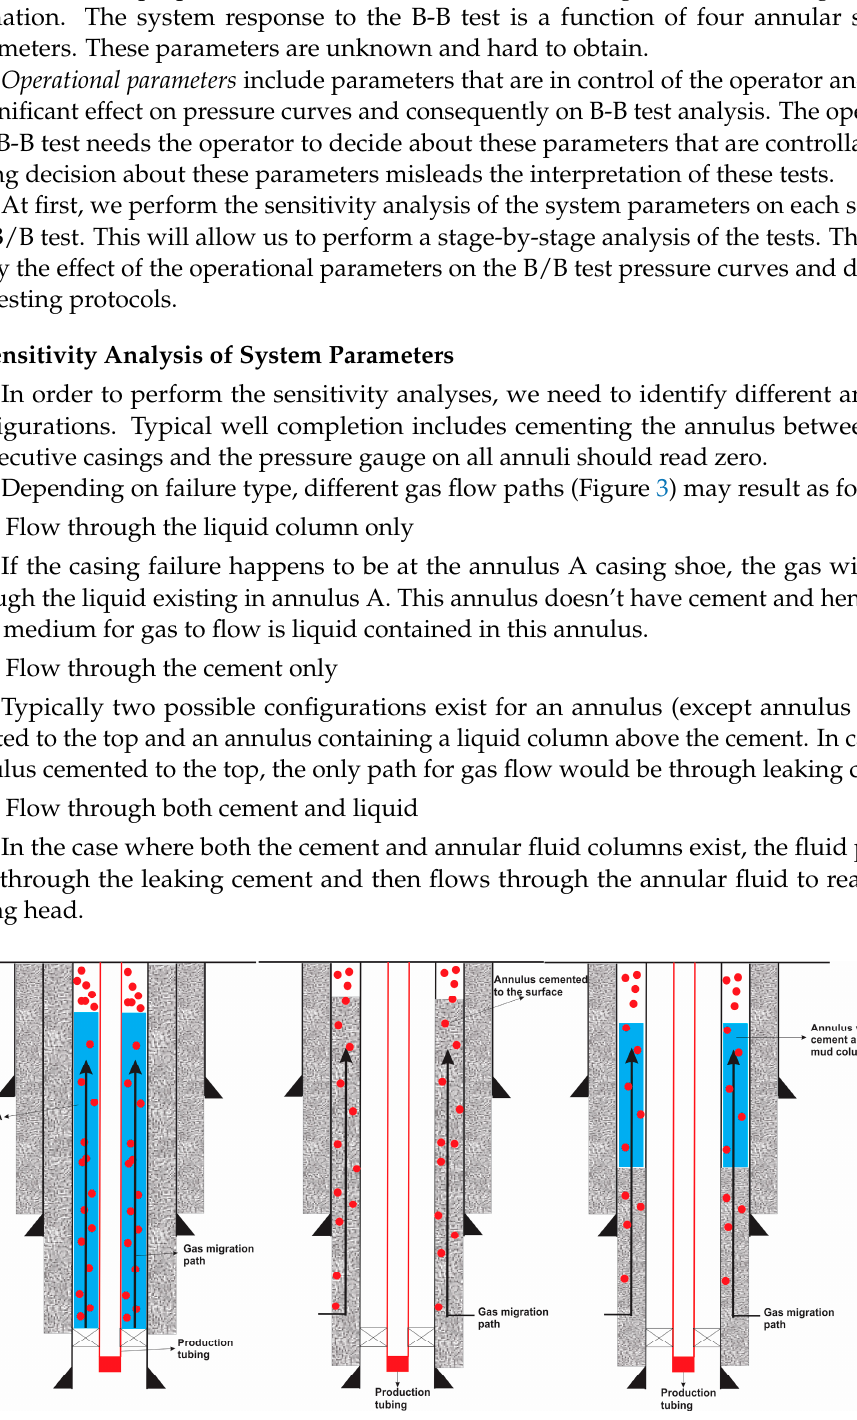
Figure 3. potential leak paths resulting in SCP.